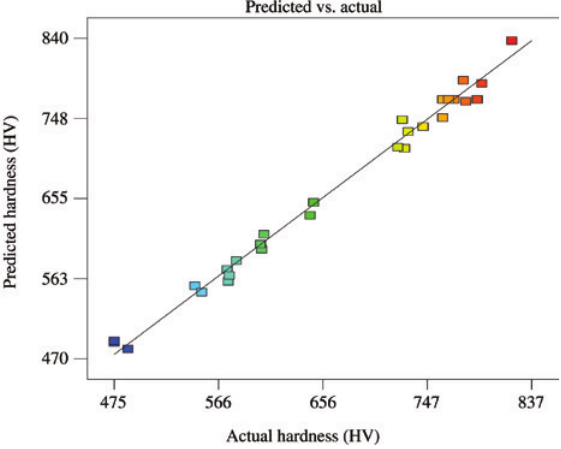
Figure 4: Correlation